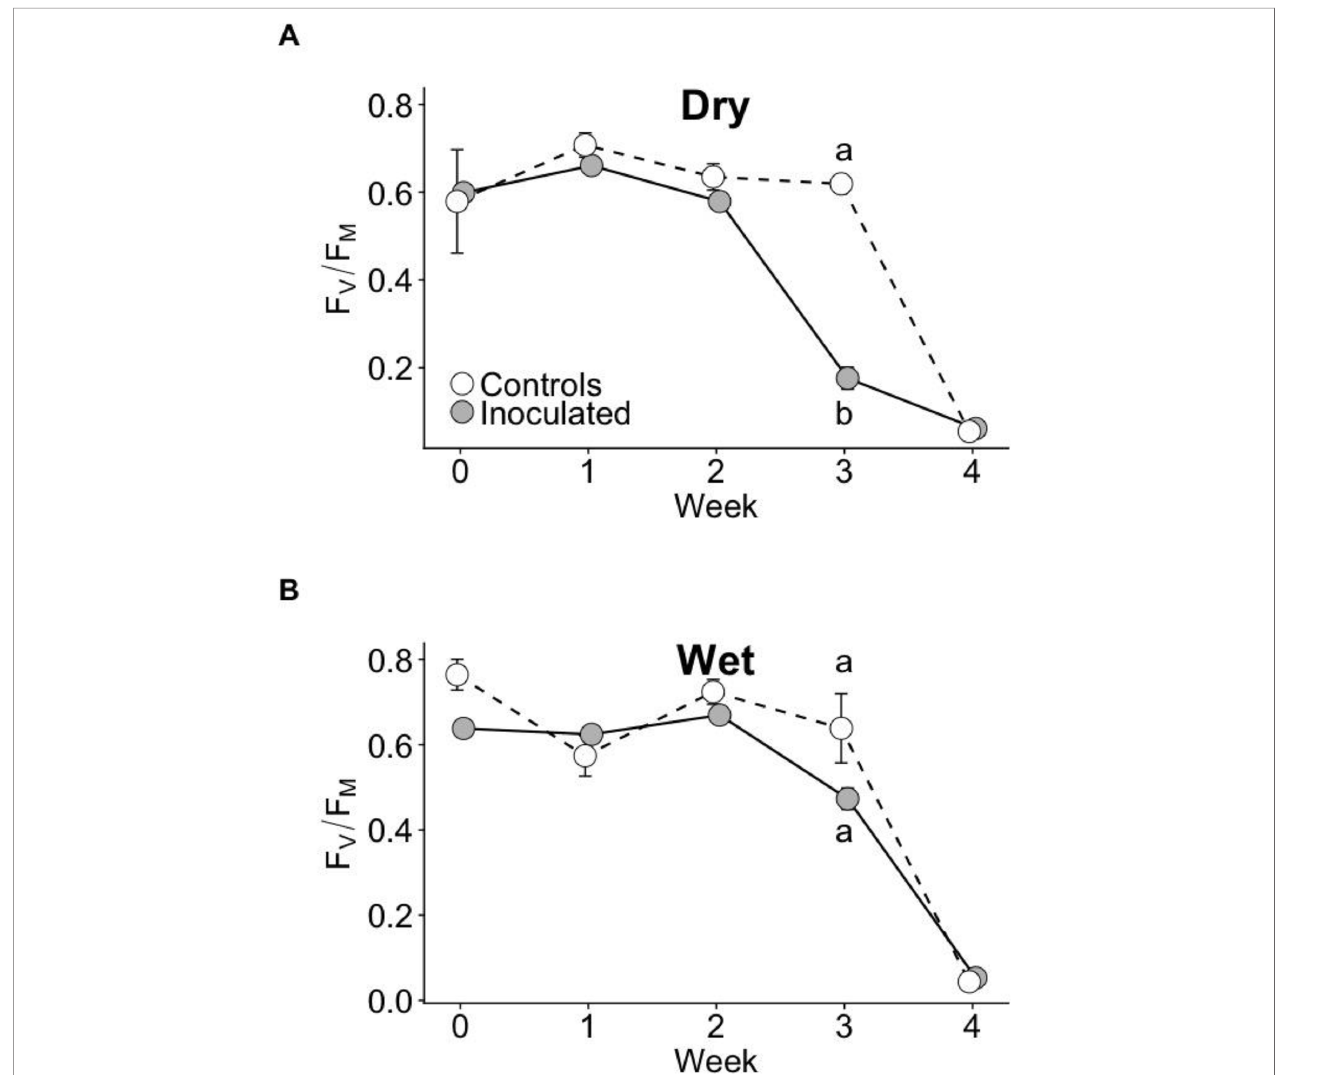
FIGURE 3 | F V /F M time courses of control and inoculated groups in dry (A) and wet (B) families measured weekly before and throughout drought. Drought was imposed after week 0 (when seedlings were ~13 months old). Error bars represent ± SE. At week 3, letters indicate statistically signi fi cant differences among the four groups at P ≤ 0.05. No signi fi cant differences among groups were detected at other time points. N =